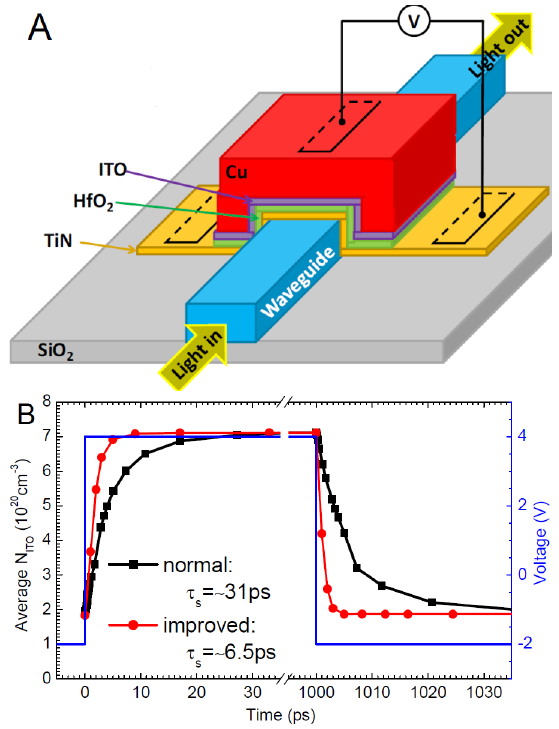
Figure 15: (A) Modulator design [141] includes two additional metal layers: TiN and Cu. (B) Numerical modeling of the change in the car- rier concentration. Cutoff frequency is approximately 11–54 GHz. Copyright (2014), OSA, from Ref. [141], with permission of the au- thors.